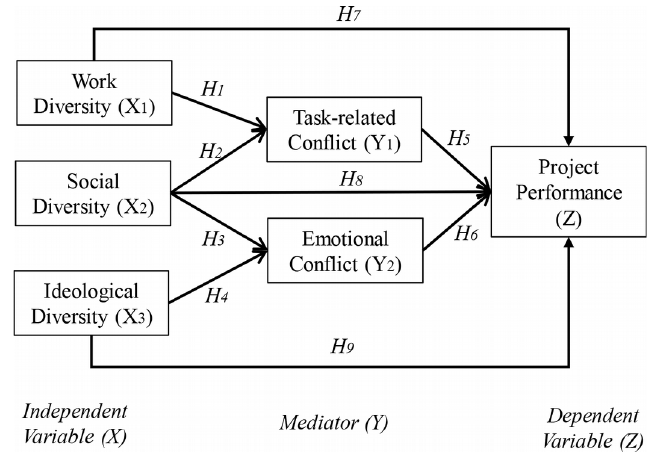
Figure 1. Proposed theoretical